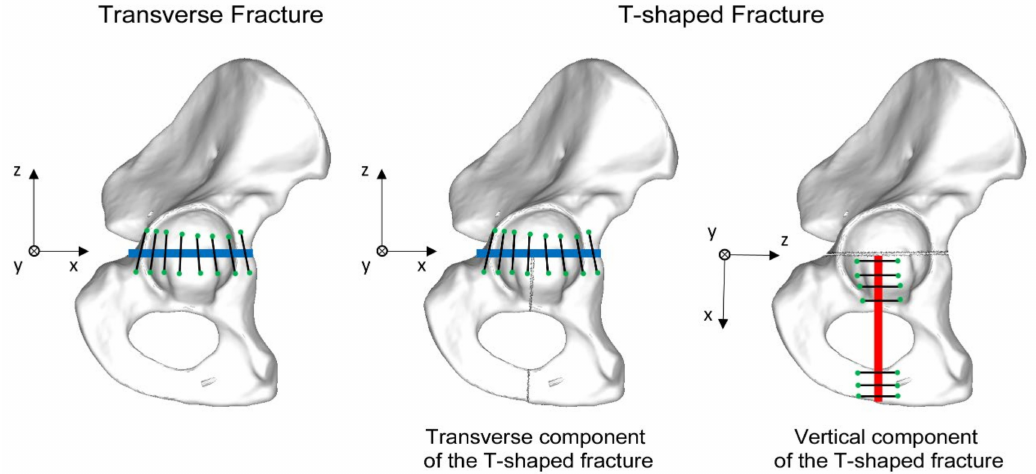
Figure 5. Reference systems and points couples selection in the transverse fracture ( left ) and in the T-shaped fracture ( right ). Note that the same blue reference system was applied for both the transverse fracture and the transverse component of the T-shaped fracture, while the red reference system was only applied for the vertical component of the T-shaped fracture. For both local reference systems, the z direction describes the compression and traction at the fracture